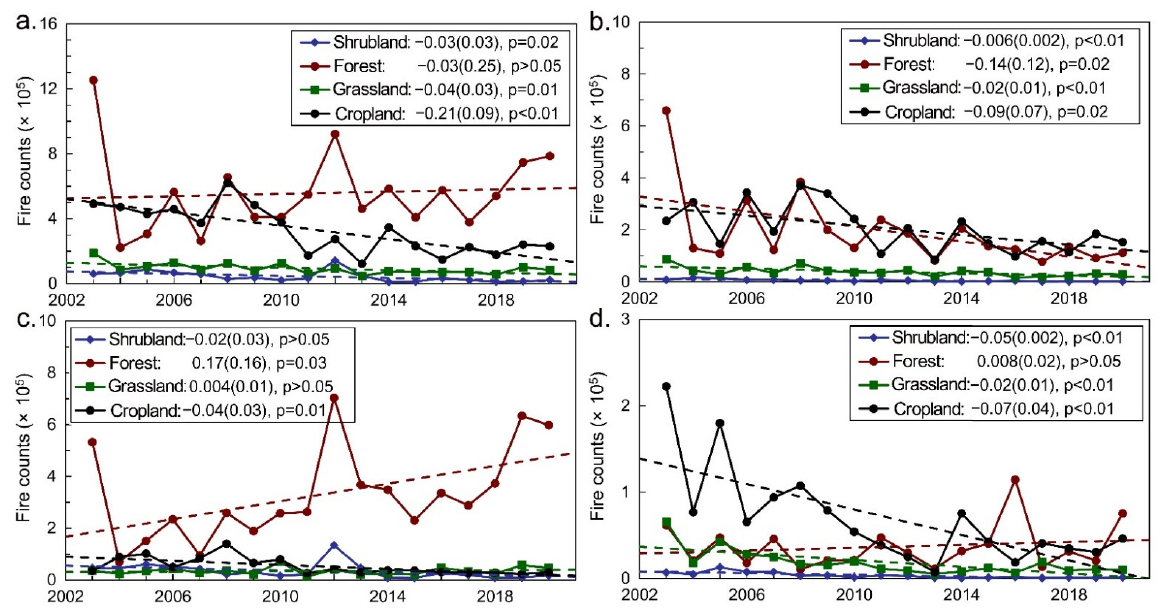
Values in brackets show standard deviations and 95% confidence intervals. Bold values are signifi- cant at the 0.05 level.